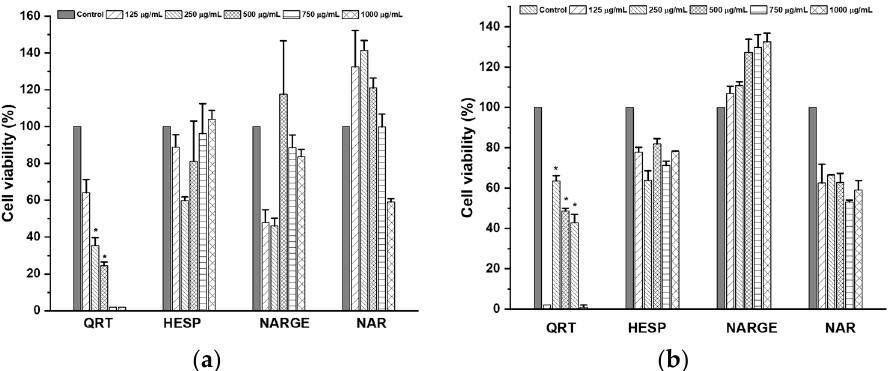
Figure 1. Percentage viability in ( a ) MDCK and ( b ) VERO cells after exposition with citroflavonoids. Non-tumorigenic cells were incubated with different concentrations of flavonoids for 48 h. Then, the MTT assay was performed. Values are presented as mean percent of viability ± standard error. n = 3, * p < 0.05.